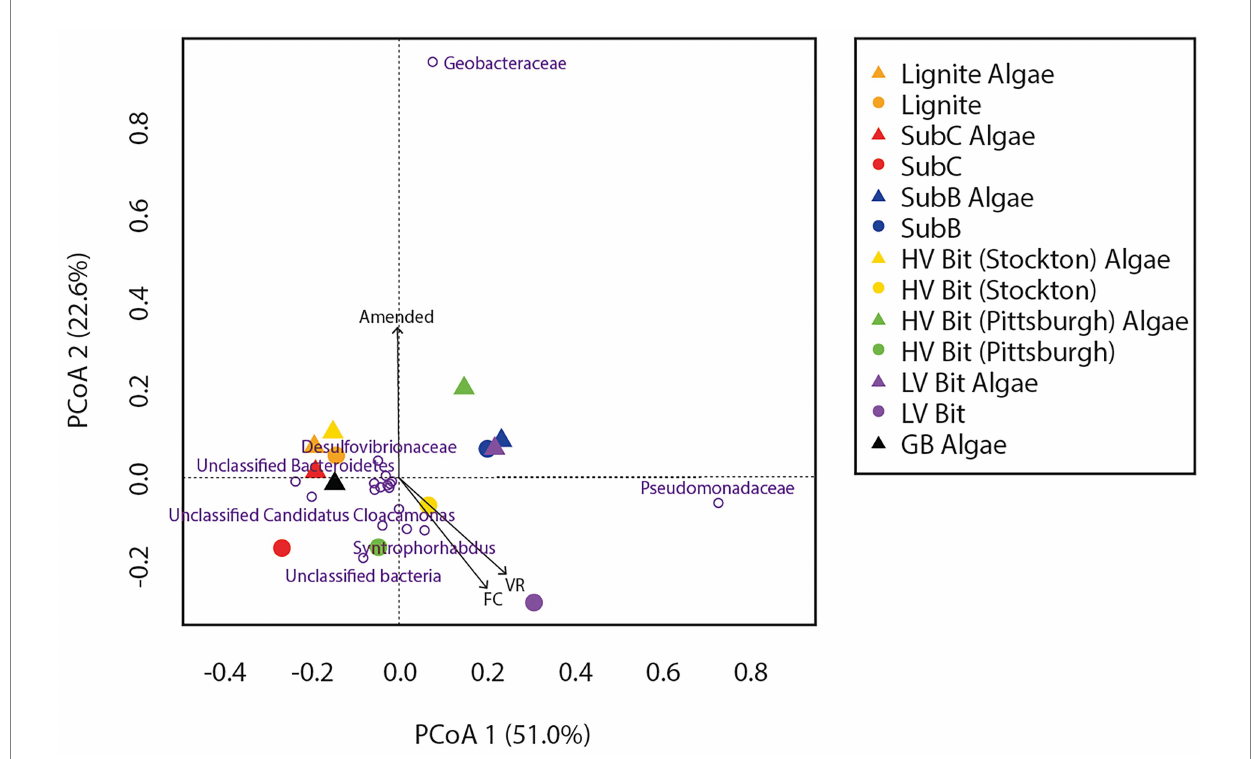
FIGURE 6 Principal Coordinate Analysis (PCoA) of non-transformed bacterial relative abundance based on OTUs combined by common phylotype with vectors representing significantly (or partially significant, p < 0.10) correlated coal composition and gas production